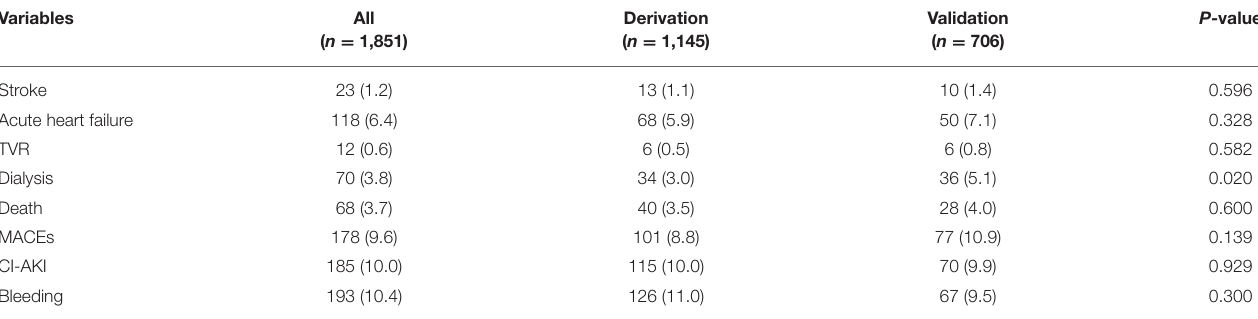
TABLE 2 | In-hospital outcomes in the model derivation and validation database. Variables